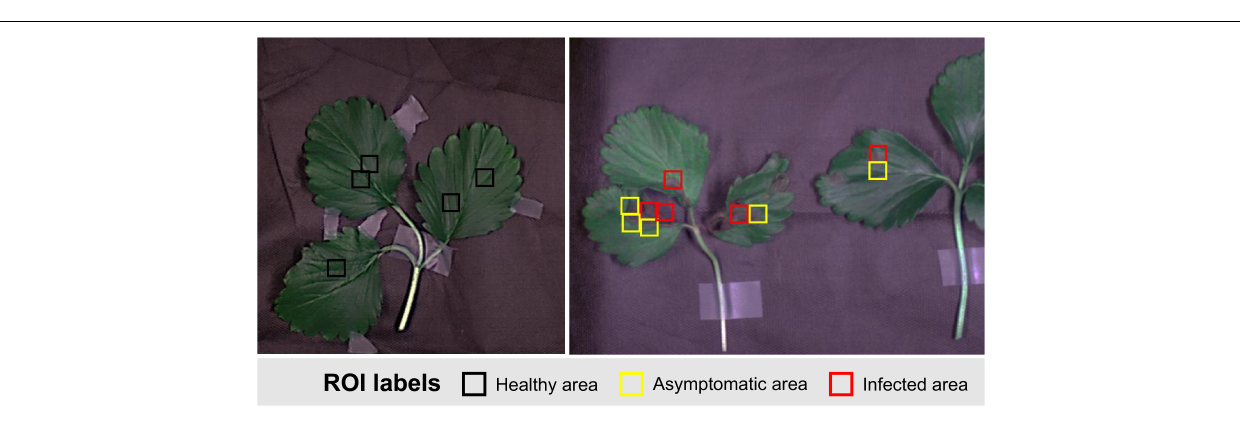
FIGURE 4 | Example of ROI selection for classification of strawberry gray mold